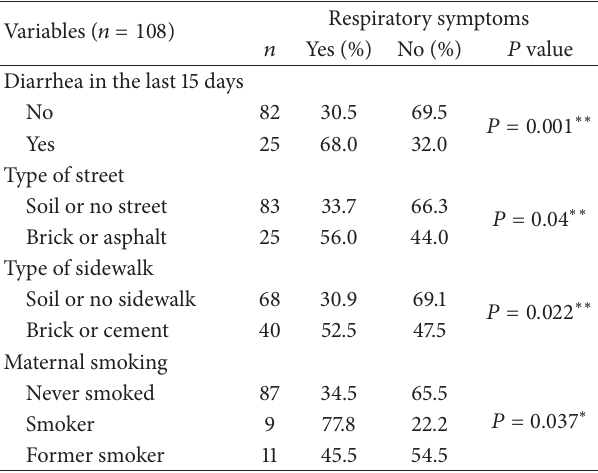
Table 6: Factors associated with respiratory symptoms in the pre- vious 15 days in children aged under 5 years,